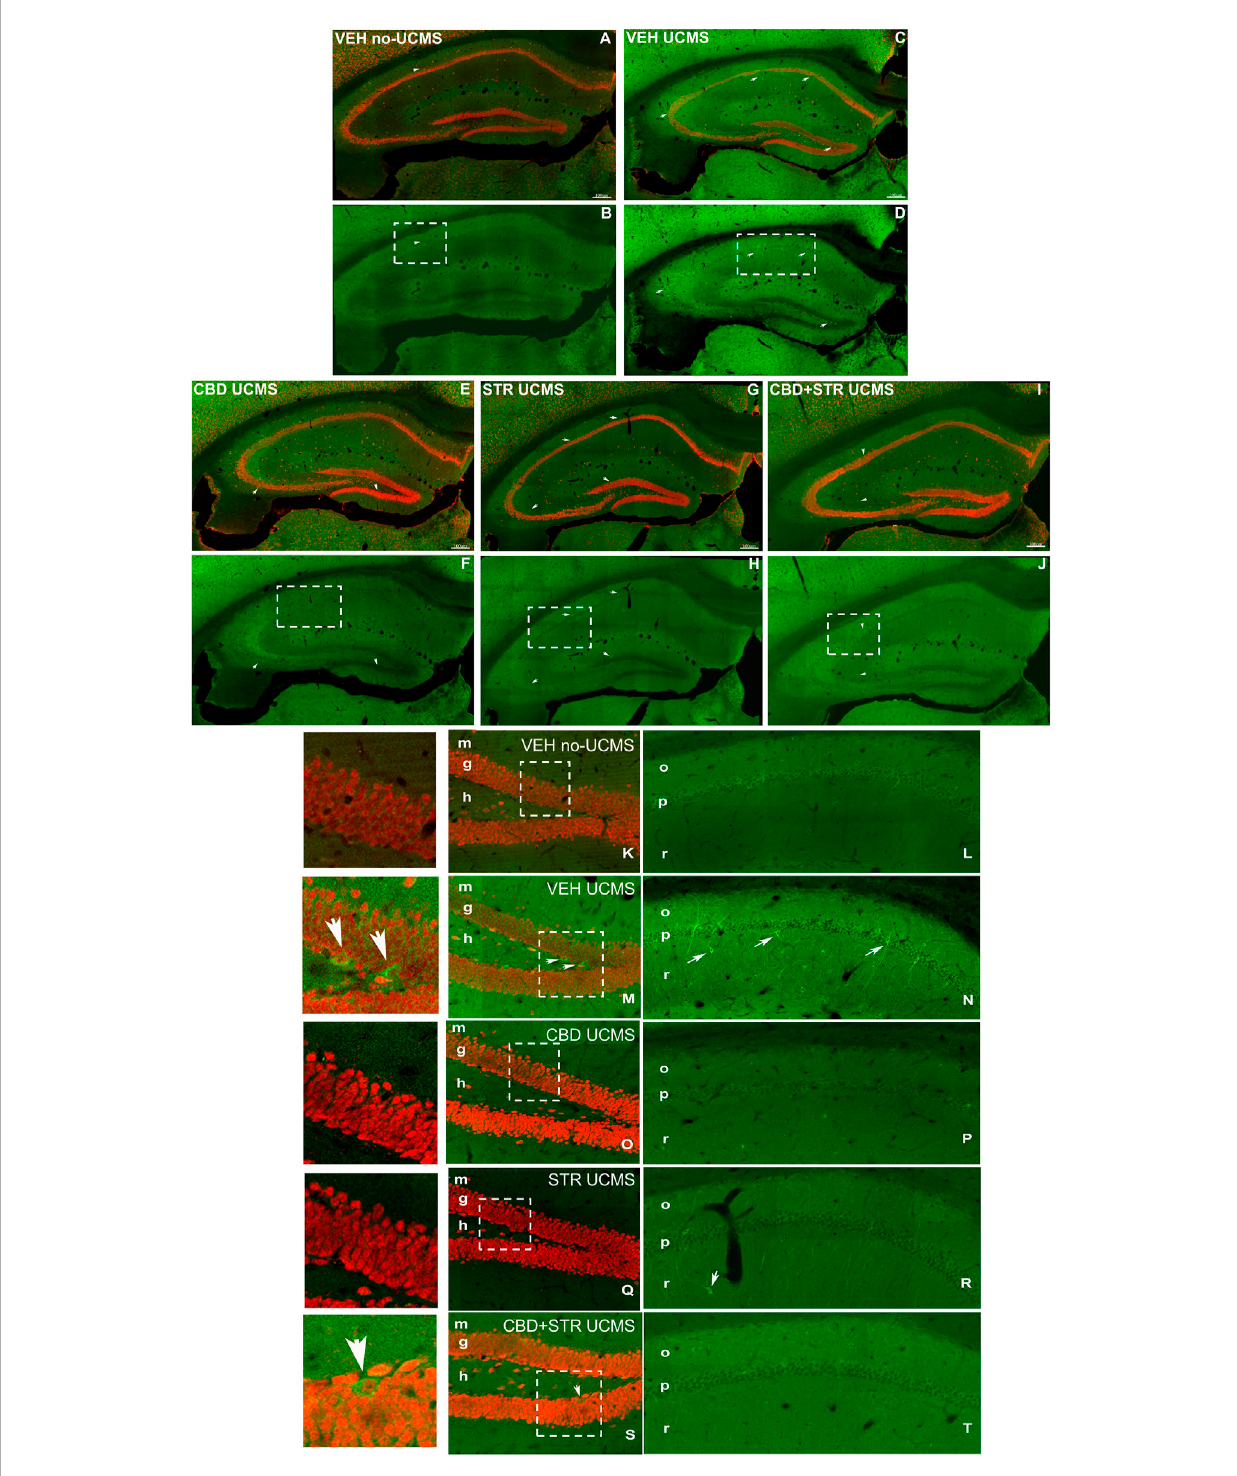
FIGURE 8 Low magni fi cation confocal image sowing NeuN/Caspase-3 double immunostaining coronal section of the hippocampus of mice exposed to the UCMS and treated with CBD, STR or their combination . Low magni fi cation photomicrographs of coronal sections of the hippocampus showing NeuN-ir neurons in red and Caspase-3-ir in green in VEH-treated non-UCMS (A, B) , VEH-treated UCMS (C, D) , CBD-treated UCMS (E, F) , STR-treated UCMS (G, H) , and CBD + STR treated UCMS (I, J) . Details of NeuN in DG (K, M, O, Q, S) and Caspase-3 (L, N, P, R, T) in CA1 of VEH-treated non- UCMS, VEH-treated UCMS, CBD-treated UCMS, STR-treated UCMS, and CBD + STR treated UCMS mice. Note the decrease of Caspase-3-ir in the granularlayerofDGandpyramidalandstratumradiatumofCA1inCBD-,STR-,andCBD+STRtreatedUCMSgroupscomparedwithVEH-treatedUCMS group. The VEH-treated UCMS (C, D) group showed an increase in Caspase-3-ir in CA1, CA3, and DG compared with the treated groups (D – I) and VEH- treatednon-UCMSgroup (A,B) .TheUCMSmicetreatedwithCBD (E,F,O,P) orCBDplusSTR (I,J,S,T) showed lower Caspase-3-ir than mice